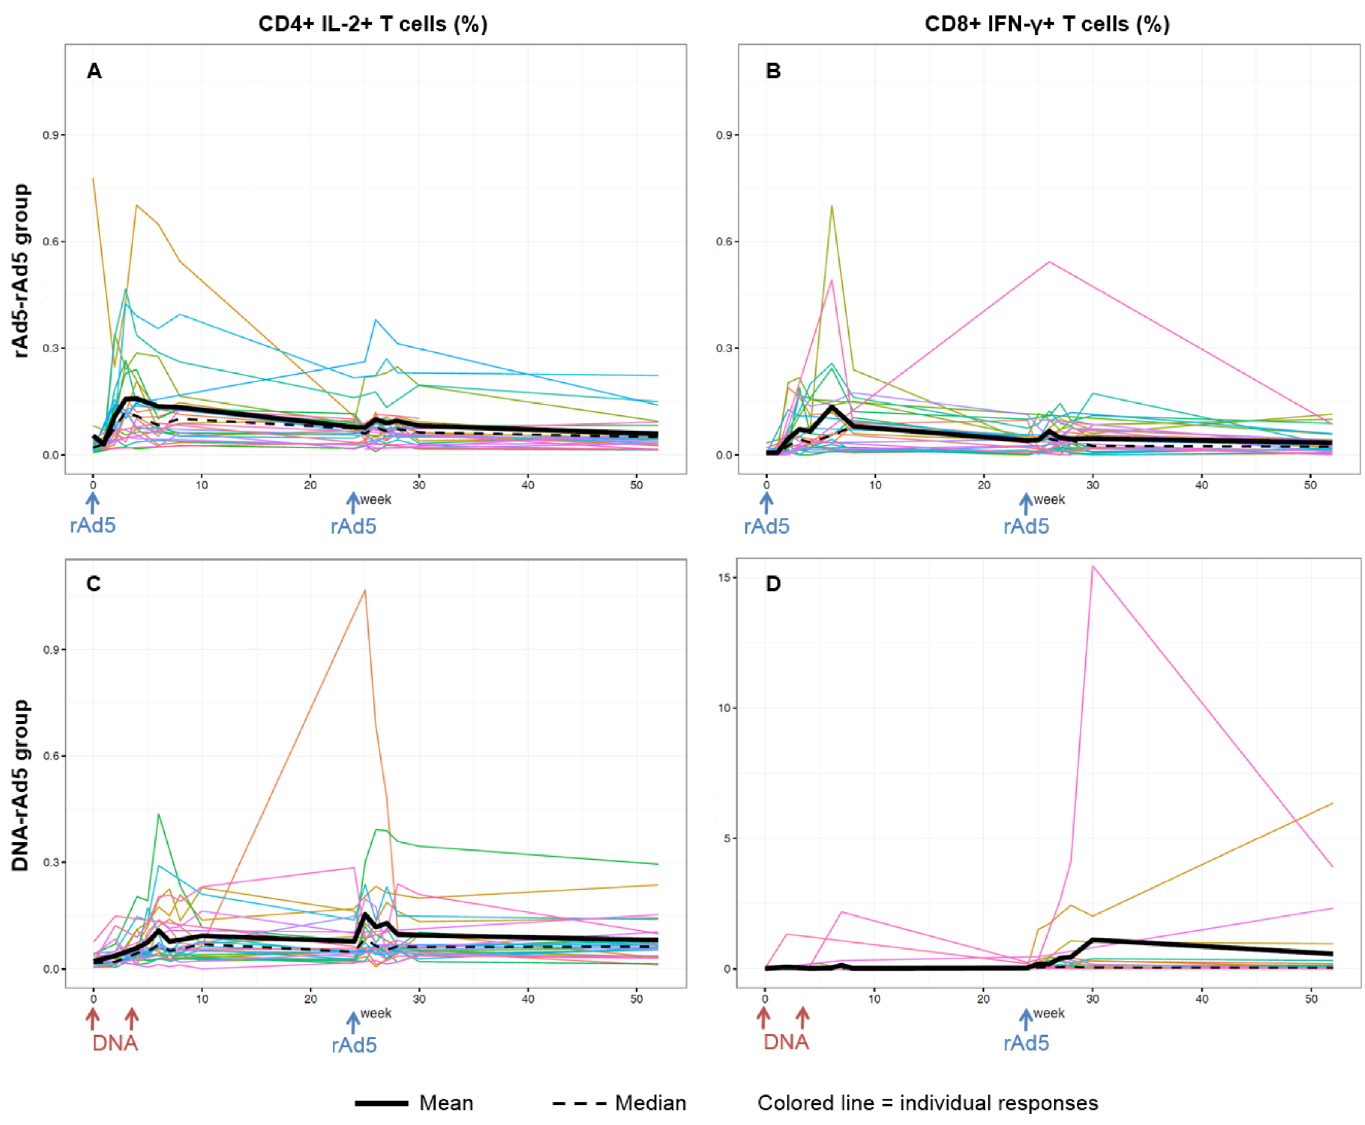
Fig 2. Kinetics of IL-2 producing CD4+ helper T cells (CD4+ IL-2+ T cells) and IFN- γ producing cytotoxic CD8+ T (CD8+ IFN- γ + T cells) responses over time after Env ex-vivo stimulation of PBMC in the rAd5-rAd5 and DNA-rAd5 groups respectively, HVTN 068 trial. (A) CD4+ IL-2+ T cells responses in the rAd5-rAd5 group. (B) CD8+ IFN- γ + T cells responses in the rAd5-rAd5 group. (C) CD4+ IL-2+ T cells responses in the DNA-rAd5 group. (D) CD8+ IFN- γ + T cells responses in the DNA-rAd5 group.